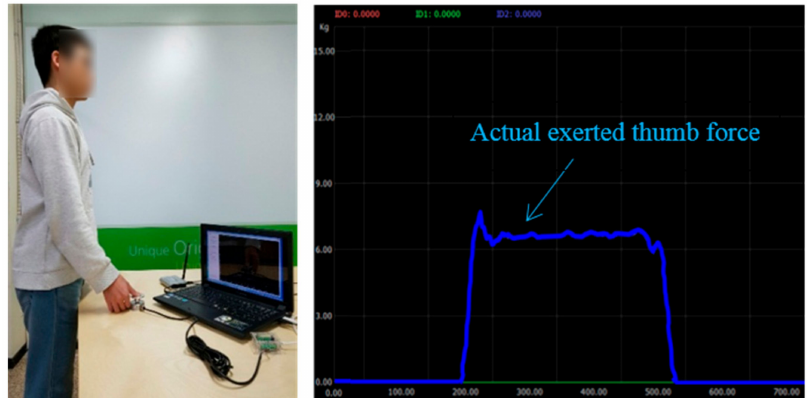
Figure 2. Experimental posture ( left ) and thumb force exertion measurement program ( right